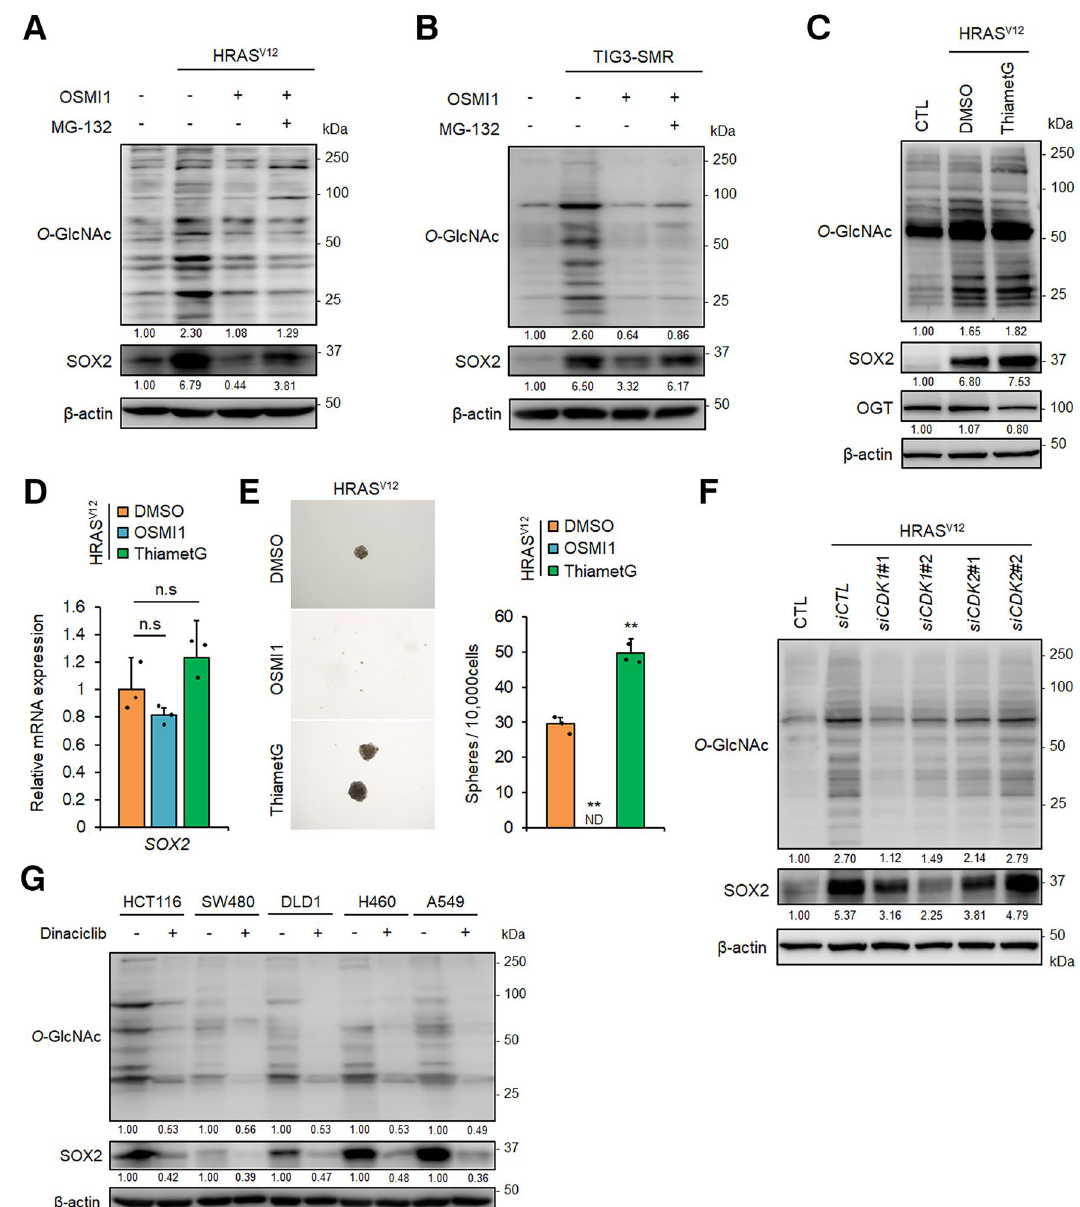
Figure 5. Enhanced O -GlcNAc modification induced by the RAS/MAPK/CDK1 pathway is required for SOX2 protein expression and generation of CSCs. ( A ) and ( B ) Immunoblot analysis of O -GlcNAc-modified proteins and SOX2 expression in HRAS V12 -expressing p53 −/− mouse embryonic fibroblasts (MEFs) ( A ) and TIG-3–SMR cells ( B ) treated with vehicle or OSMI1 (50 µM) for 24 h in the presence or absence of MG-132 (20 μM) for 6 h. ( C ) Immunoblots of O -GlcNAc modified proteins and SOX2 expression in HRAS V12 -expressing p53 −/− MEFs treated with vehicle or thiamet G (10 µM) for 24 h. ( D ) Expression levels of SOX2 mRNA in HRAS V12 - expressing p53 −/− MEFs cells treated with OSMI1 (50 µM) or thiamet G (10 µM) for 24 h. n. s., not significant. ( E ) Sphere formation assay of HRAS V12 -expressing p53 −/− MEFs cultured with OSMI1 (50 µM) or thiamet G (10 µM) for 7 days. Representative images are shown on the left; the graph on the right shows quantification of the numbers of spheres counted per 10,000 cells. ND, not detected. **P < 0.01. ( F ) Expression levels of O -GlcNAc-modified proteins and SOX2 in HRAS V12 -expressing p53 −/− MEFs following knockdown of CDK1 or CDK2 by siRNAs. ( G ) Immunoblot analysis of SOX2 and O -GlcNAc levels in HCT116, SW480, DLD1, H460, and A549 cancer cells treated with dinaciclib (0.1 µM) for 24 h. Data for D and E are presented as the means ± SD of three independent experiments. Statistical analysis was performed with Student’s t-tests. ( A )–( C ), ( F ) and ( G ): The band intensity is provided under each band. The intensity in panel ( G ) was compared with vehicle-treated control cells for each cell line. Uncropped blot images are presented in Supplementary Fig.